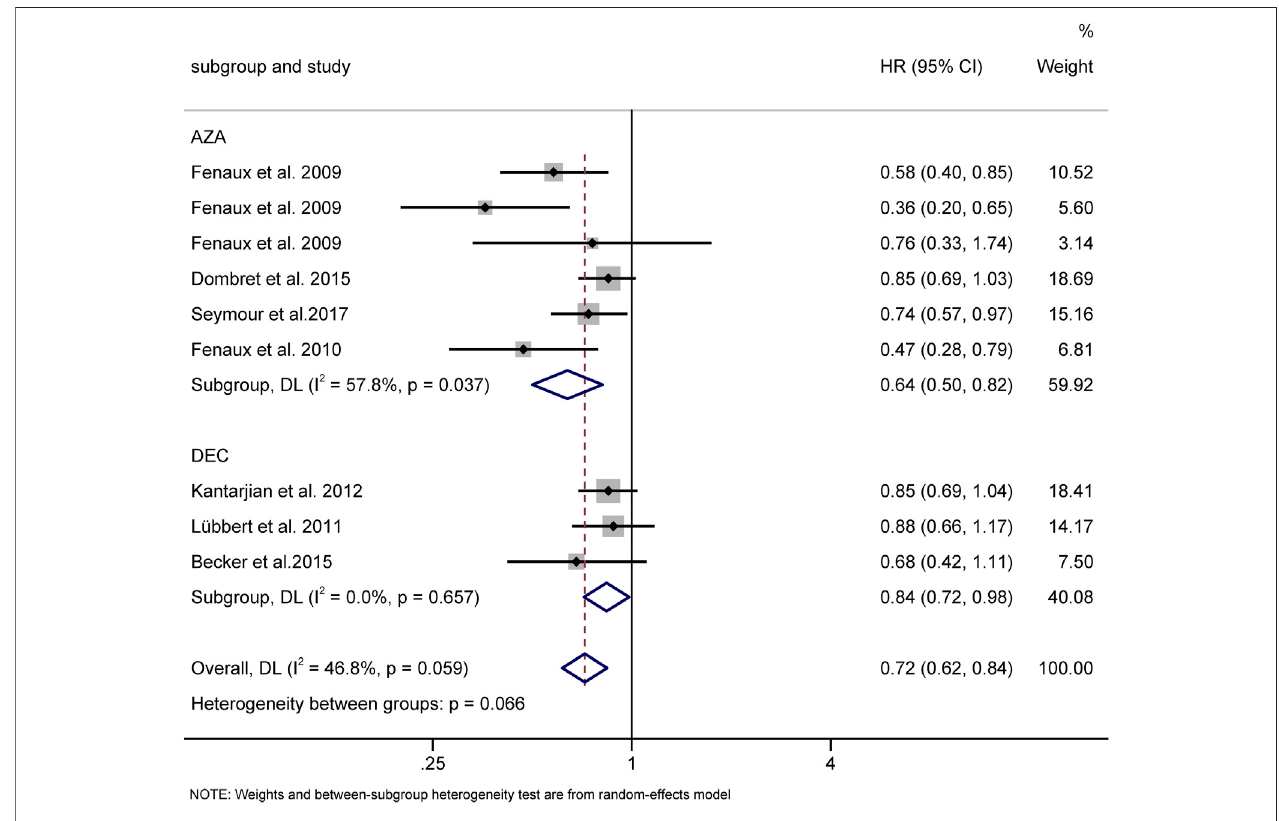
FIGURE 10 | Overall survival of AZA and DAC compared to CCR. AZA, azacitidine; Dec, decitabine; CCR, conventional care regimens.